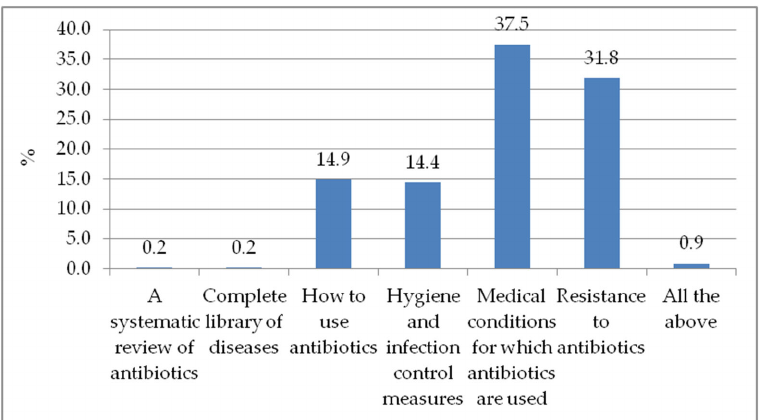
Figure 1. The topics on which to receive more information about.